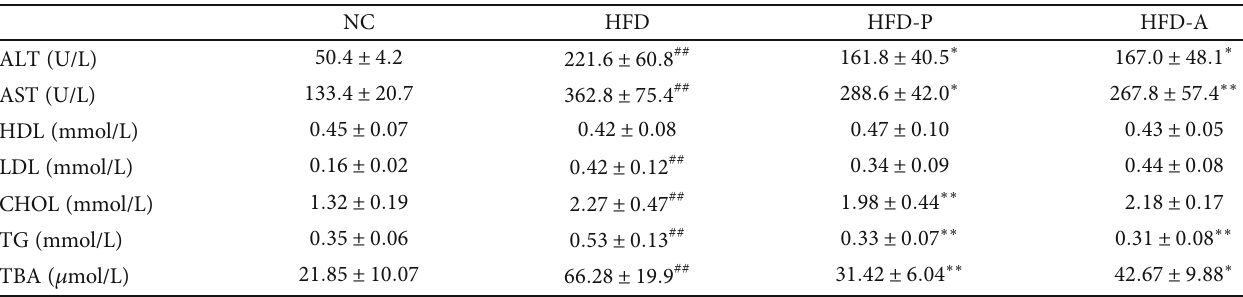
Figure 2: E ff ect of probiotics on the histology of liver tissue induced by HFD in NAFLD rats. (a) HE staining results: (A) NC group; (B) HFD group; (C) HFD-P group; (D) HFD-A group ( × 200 magni fi cation). (b) NAFLD activity score results. ## P < 0 : 01 versus the NC group; ∗∗ P < 0 : 01 versus the HFD group. Table 2: Biochemical indexes in all